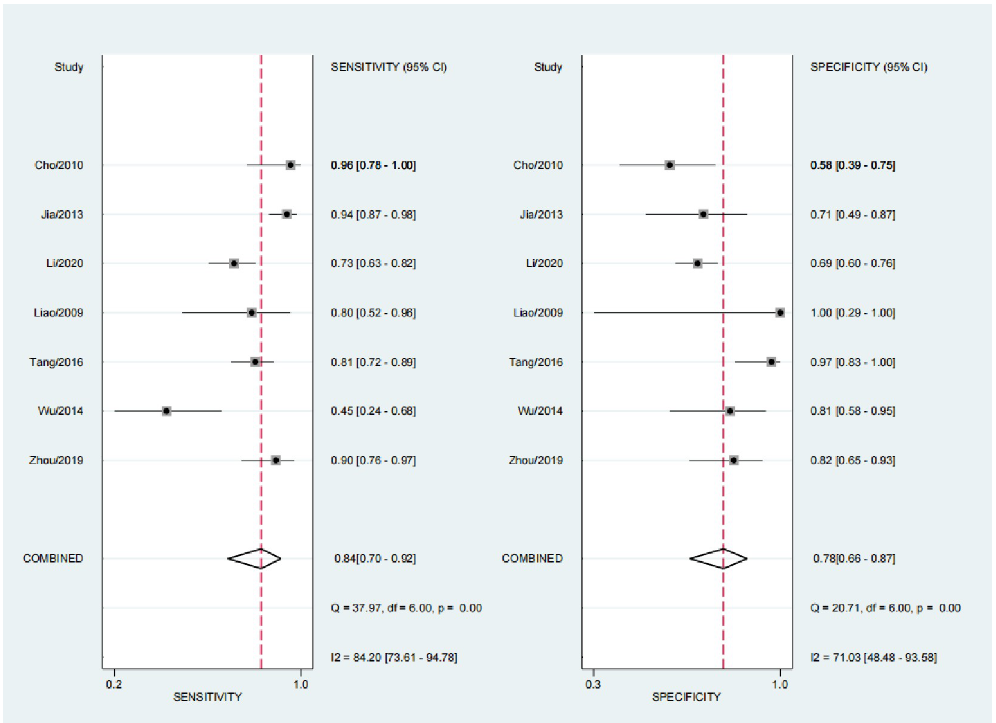
Fig 3. Evaluation of the sensitivity and specificity of interferon- γ release assay in the diagnosis of OATB: A study forest plot. Filled squares represent sensitivity/specificity estimates from studies done using. interferon- γ release assay. See references 24 to 30 for details. Thresholds for the interpretation of I2 are as follows: 0% to 40%: might not be essential; 30% to 60%: may represent moderate heterogeneity; 50% to 90%: may represent substantial heterogeneity; 75% to 100%: considerable